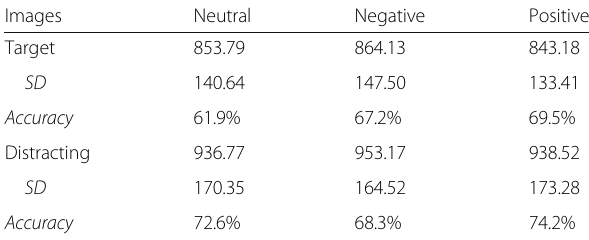
Table 2 Response time averages (ms), error rate, and standard deviation (SD) for different experimental